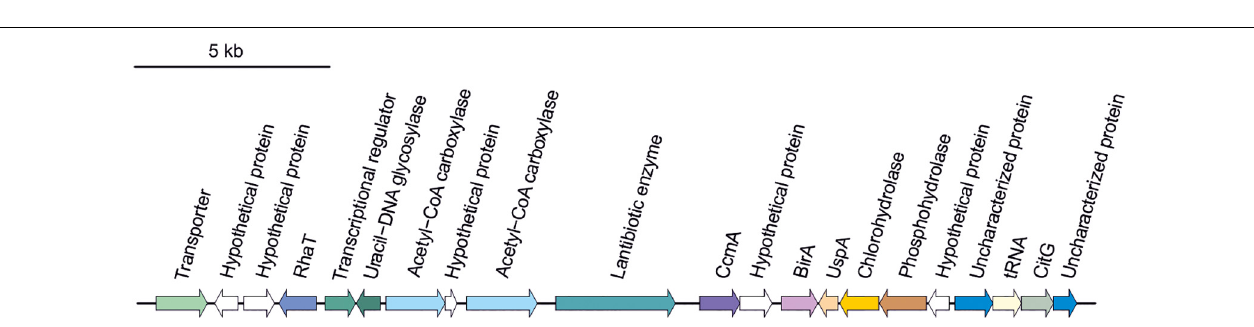
FIGURE 5 | Thiopeptide biosynthetic gene clusters identified in Halomicroarcula genomes: (A) Strain F24A T and (B) Halomicroarcula pellucida CECT 7537 T .